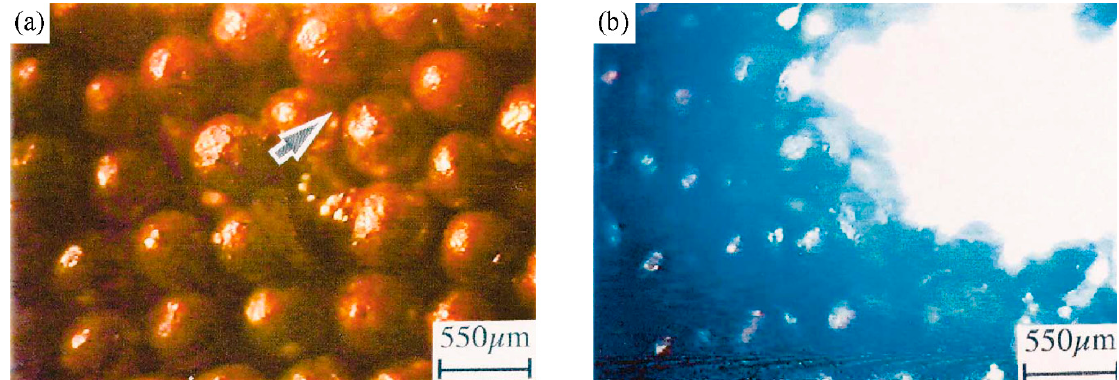
Figure 4. ( a ) Cu powder particles 550 µm in diameter. ( b ) Generation of an electric arc by a current pulse of 6700 A/cm 2 during 100 ms, at the location indicated by an arrow in Figure ( a ) [8]. Reproduced with permission from Materials Science and Engineering: A , published by Elsevier, 2003.